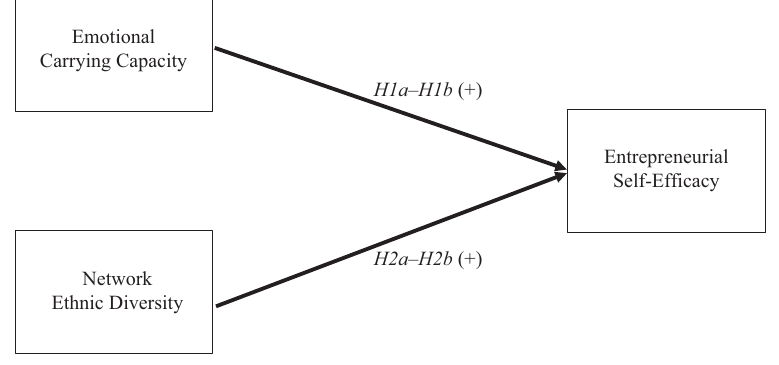
Figure 1. Hypothesized